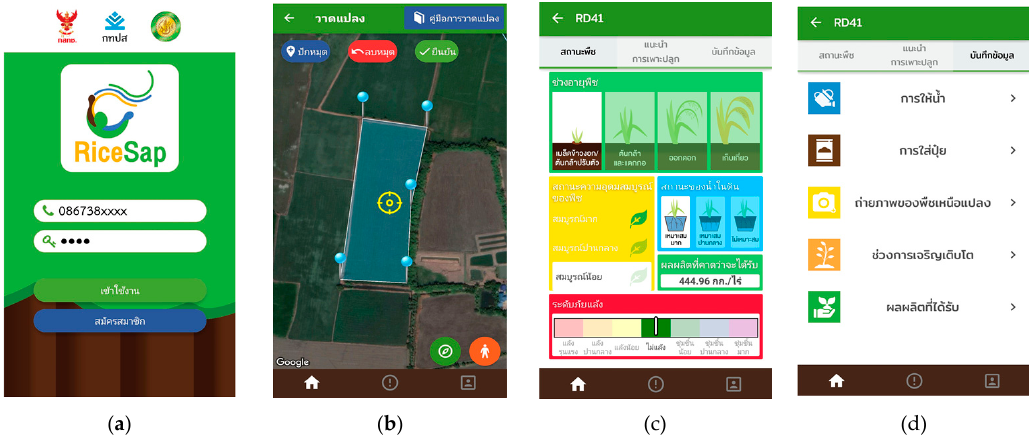
Figure 15. The RiceSAP mobile app: ( a ) welcome screen, ( b ) farmland registration, field practice, crop variety and planting date inputs; ( c ) crop monitoring functions, including rice stage, crop health, soil moisture, yield forecast and drought vulnerability index; ( d ) crop suggestion and management functions including watering and fertilizer schedules, taking crop photos, recording crop stages and actual